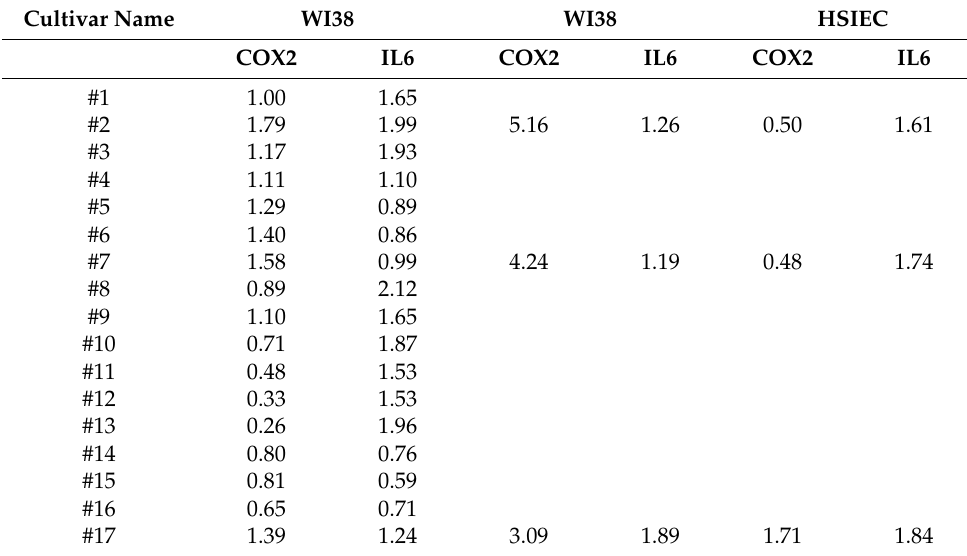
Table 2. Anti-inflammatory effect of cannabis